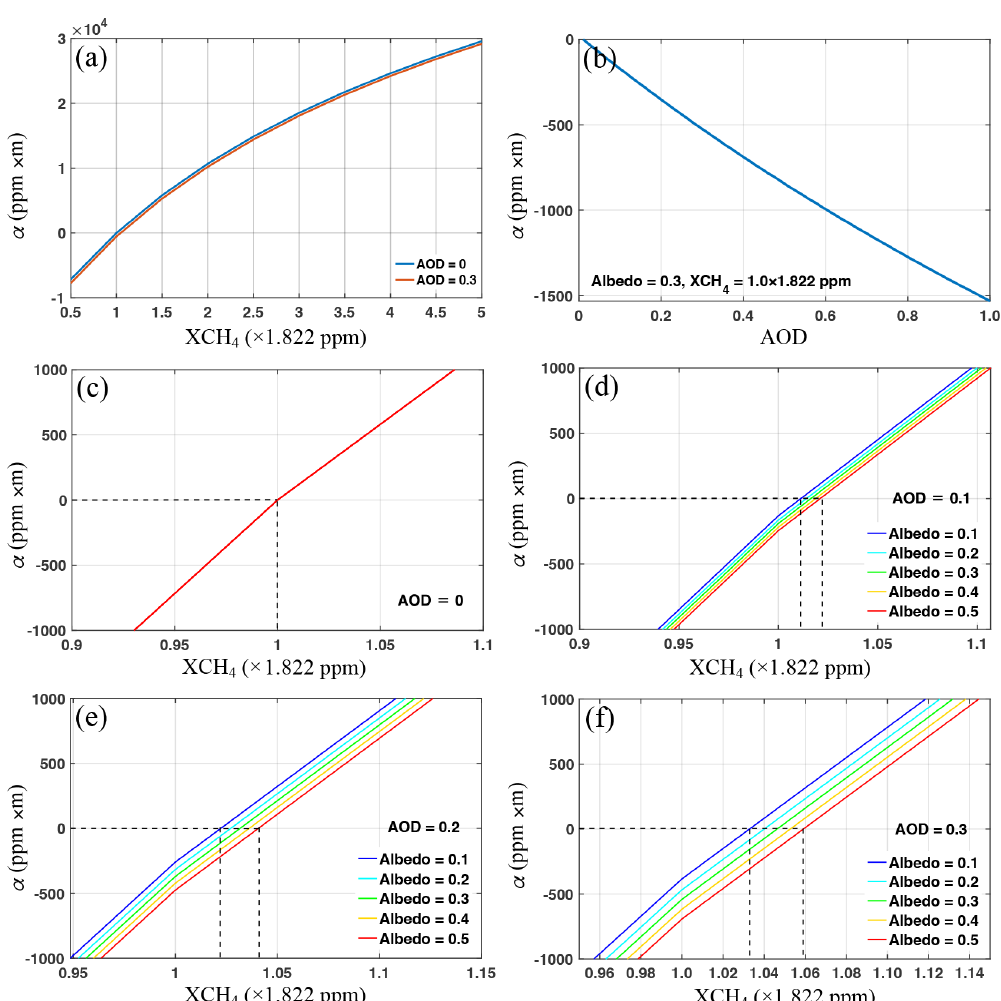
Figure 5. (a) α as a function of XCH 4 for AOD = 0 and AOD = 0 . 3 (surface albedo = 0 . 3). (b) α as a function of AOD (XCH 4 = 1 . 0 × 1 . 822ppm, surface albedo = 0 . 3). Zoomed-in versions of α as a function of XCH 4 for different surface albedos (0.1–0.5), where (c) AOD = 0, (d) AOD = 0 . 1, (e) AOD = 0 . 2, and (f) AOD = 0 . 3.